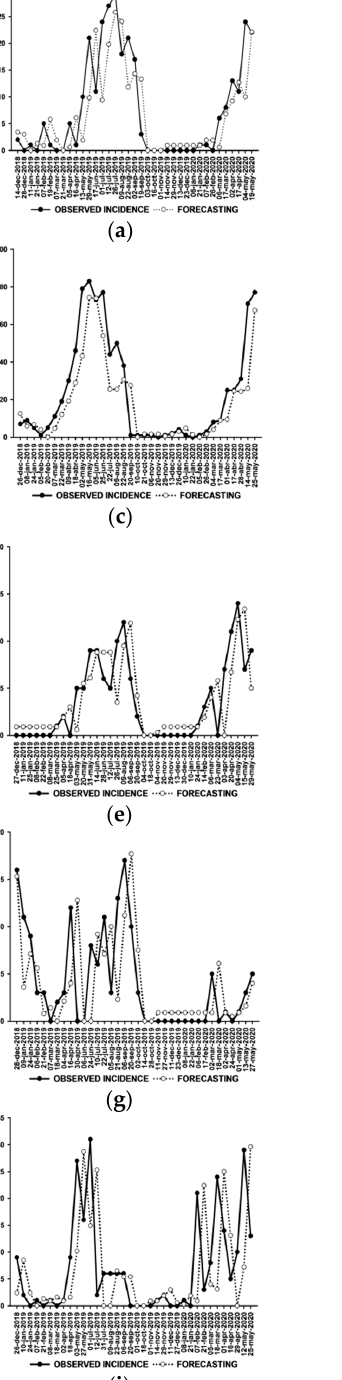
( b ) Figure 2. Interface for viewing the phytosanitary warning in the municipalities of Carmo do Rio Claro, Monte Santo de Minas, Nova Resende, Rio Paranaíba and Serra do Salitre in the state of Minas Gerais, Brazil: ( a ) DSS 1; ( b ) DSS 2. The visualization and understanding of the warnings were simplified by the use of the traffic light color system, where green meant “with no probability of occurrence of